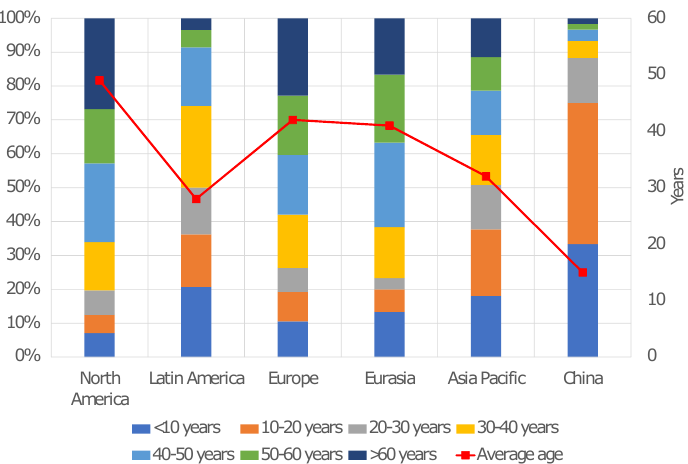
Figure 1. Worldwide hydropower age profile of installed plants. Built with data from